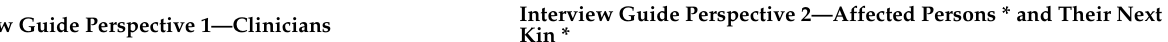
Table 1. Guides for semi-structured interviews for (1) clinicians and (2) affected persons and their next of